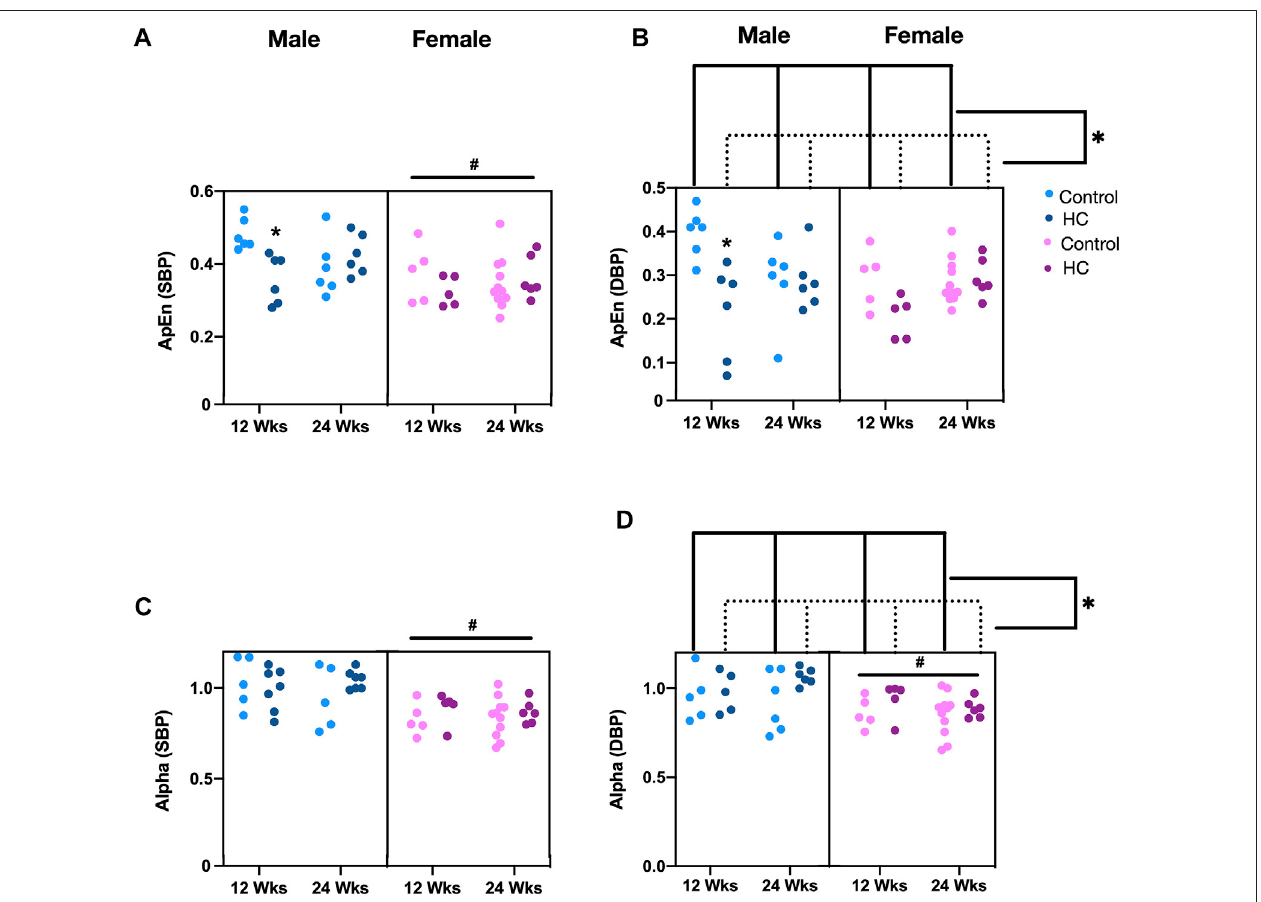
FIGURE6| Impact ofHC-feeding onnonlinear parametersofbeat-to-beatsystolicand diastolic bloodpressure(SBP andDBP, respectively)inratsofeithersex in different feeding duration groups. (A,B) Approximate entropy (ApEn) and (C,D) α of detrended fl uctuation analysis of SBP and DBP, respectively, in control and HC-fed ratsofeithersexindifferentfeedingdurationgroups.Statisticalanalysiswasperformedbythree-wayANOVAfollowedbySidak ’ smultiplecomparisonstest.*denotesa p < 0.05 vs. control of the same feeding duration and sex (control vs. HC), while # denotes a p < 0.05 vs. the corresponding male group (males vs. females).